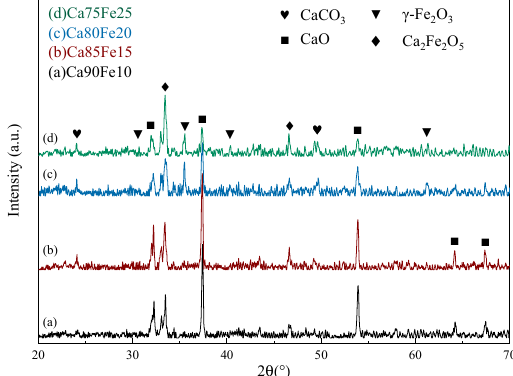
Figure 4. XRD patterns of the catalysts.